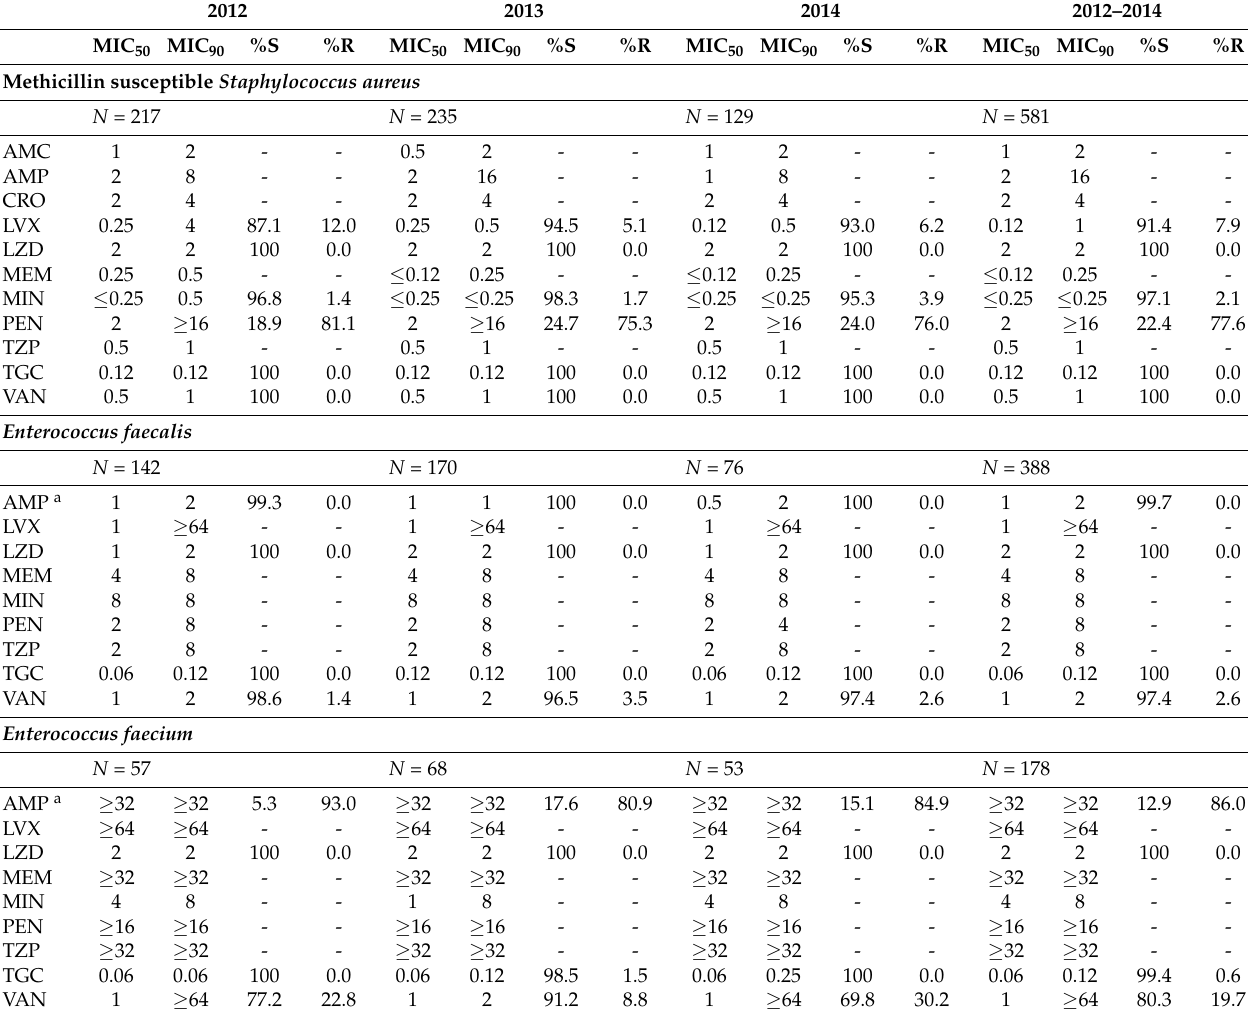
Table 4. Antimicrobial activity among Gram-positive organisms collected in Italy between 2012 and